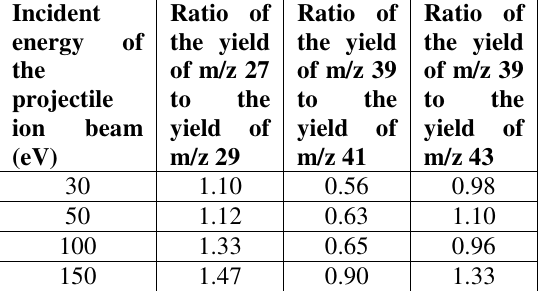
TABLE 1. RESPECTIVE RATIOS OF THE SECONDARY ION YIELDS AFTER COLLISION OF AR + ON PS-W.